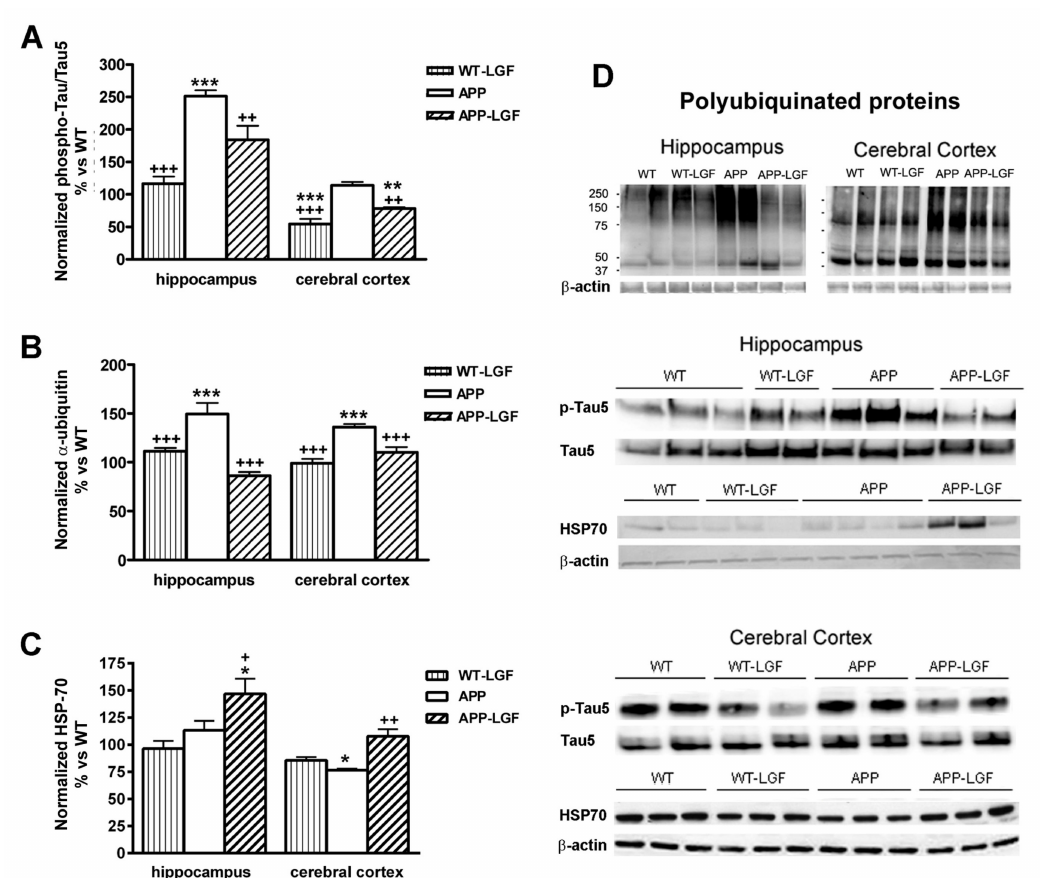
Figure 3. E ff ects of LGF in tau pathology, ubiquitinated protein levels and HSP70 heat shock protein expression. Panel ( A ), shows the relative optical density of phospho-tau / tau ratio analyzed by Western blot and expressed as % vs. WT. Note how LGF treatment reduces the expression of phosphorylated tau in the hippocampus and cerebral cortex in APP mice. Panels ( B , C ) show the quantification of accumulated ubiquitinated proteins ( B ) and HSP-70 ( C ) in the hippocampus and cerebral cortex of APPswe mice. Note how LGF reduces the accumulation of ubiquitinated proteins ( B ) and increases HSP70 expression ( C ). Panel ( D ) shows representative Western blot images of phospho-tau, total tau, Hsp-70 and β -actin as charge control. Results represent the mean ± SEM of 4 to 8 independent mice. The statistical analysis was performed by one-way ANOVA followed by Newman–Keuls test. * p ≤ 0.05, ** p ≤ 0.01, *** p ≤ 0.001 vs. WT. + p ≤ 0.05, ++ p ≤ 0.01, +++ p ≤ 0.001 vs. APPswe